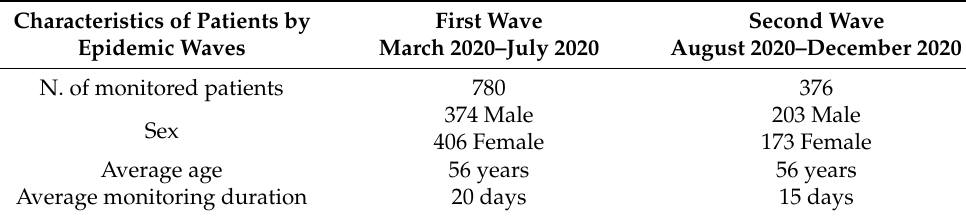
Table 4. Characteristics of patients by epidemic